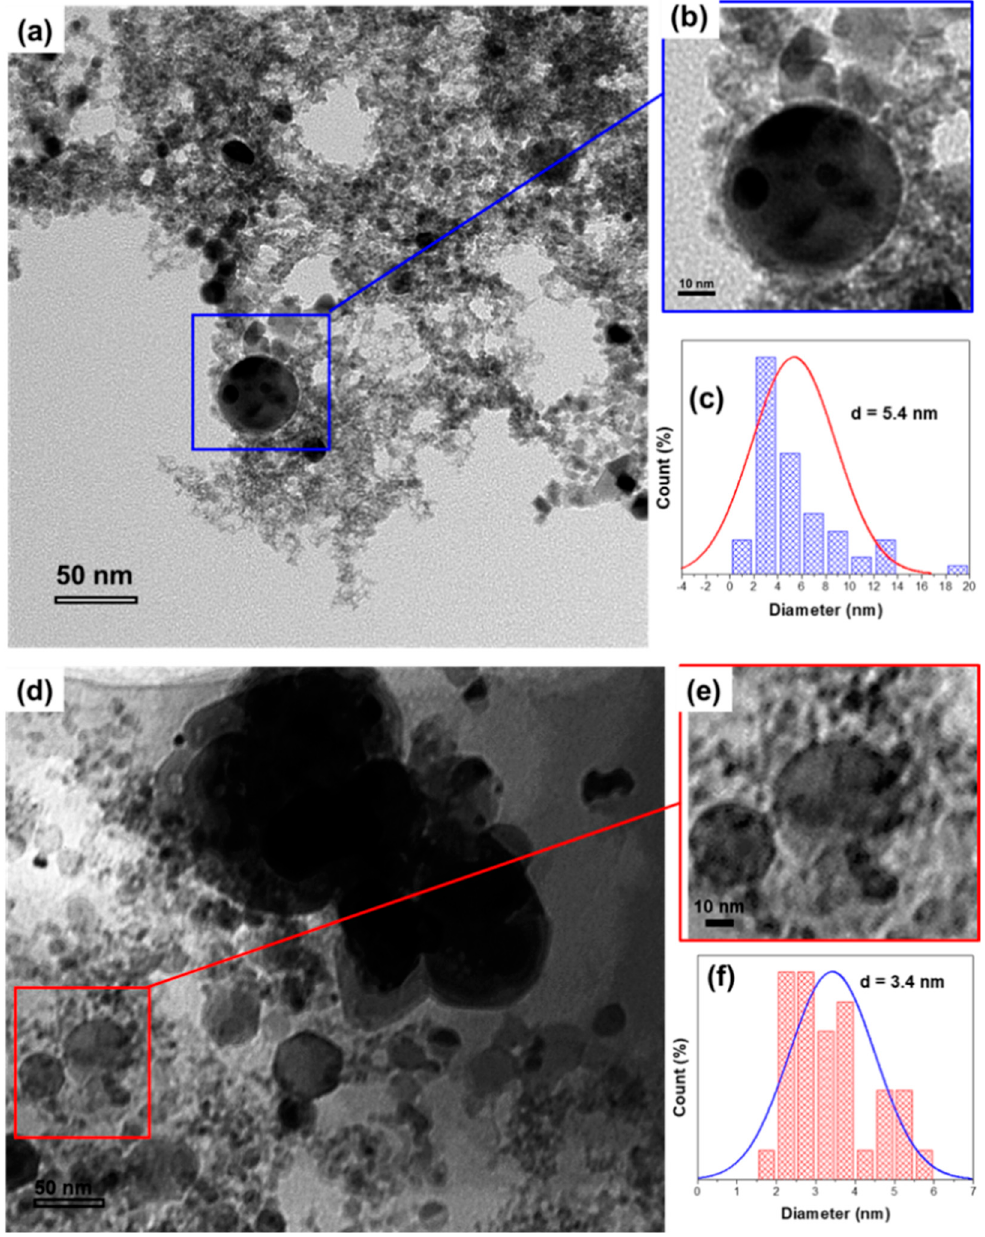
Figure 3. TEM micrographs and particle size distribution of fresh Au/CeO 2 prepared by the physical method (LVCC) ( a – c ) and the chemical method (DP) ( d – f ).